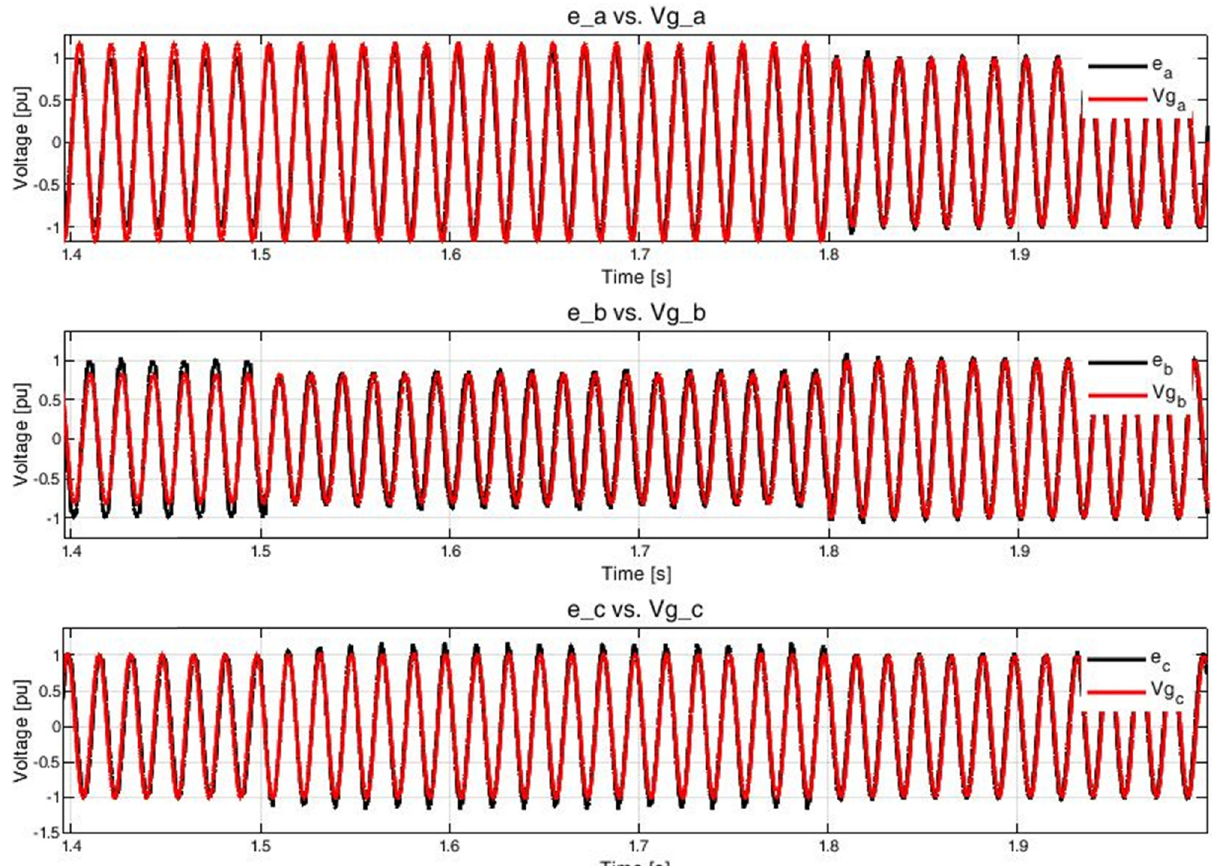
Figure 9: Comparison between per - phase inverter and grid